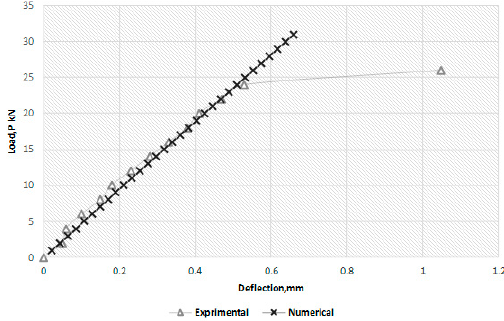
Fibers 2020 , 8 , x FOR PEER REVIEW Figure 26. Load–deflection diagram of beam (B4).